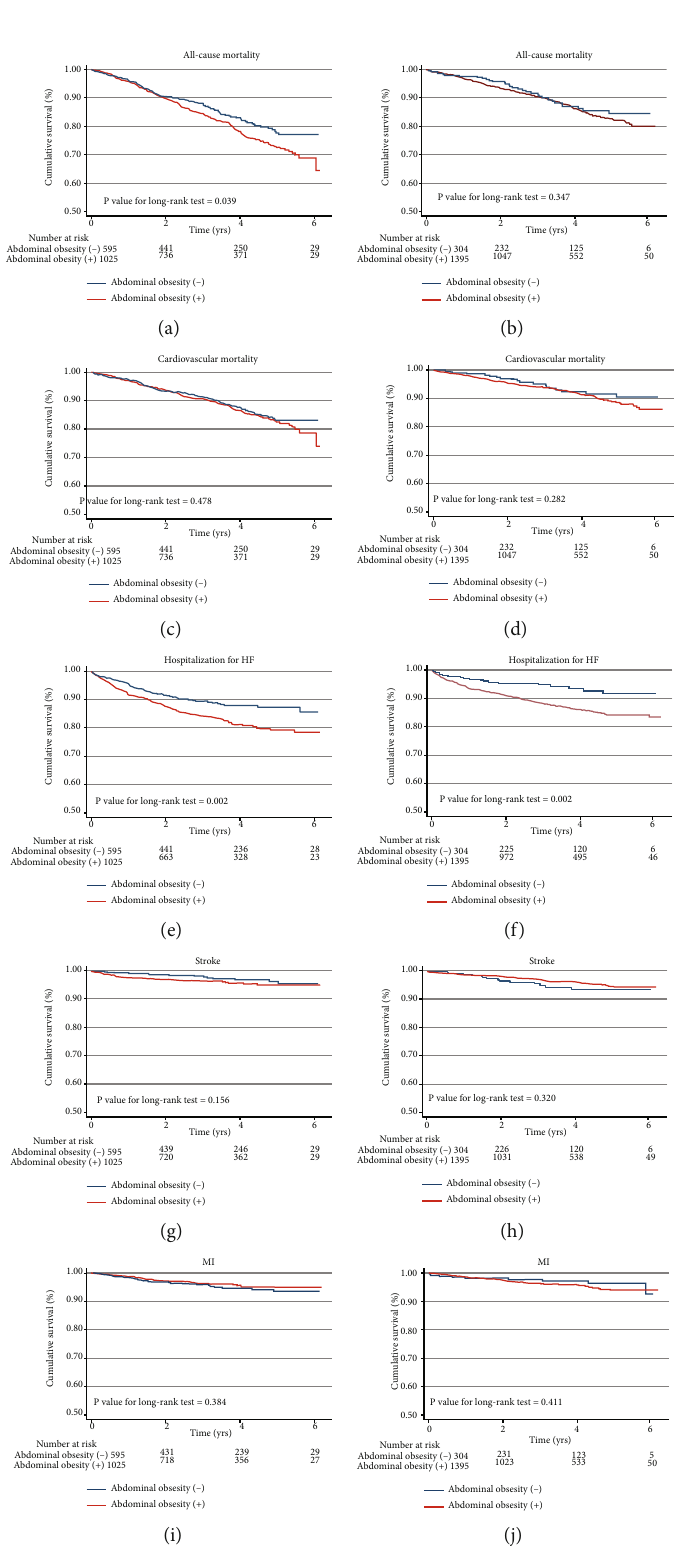
Figure 1: Kaplan-Meier survival curves and cumulative event rates for all-cause mortality in male (a) and female (b); cardiovascular mortality in male (c) and female (d) hospitalization for HF in male (e) and female (f); stroke in male (g) and female (h); MI in male (i) and female